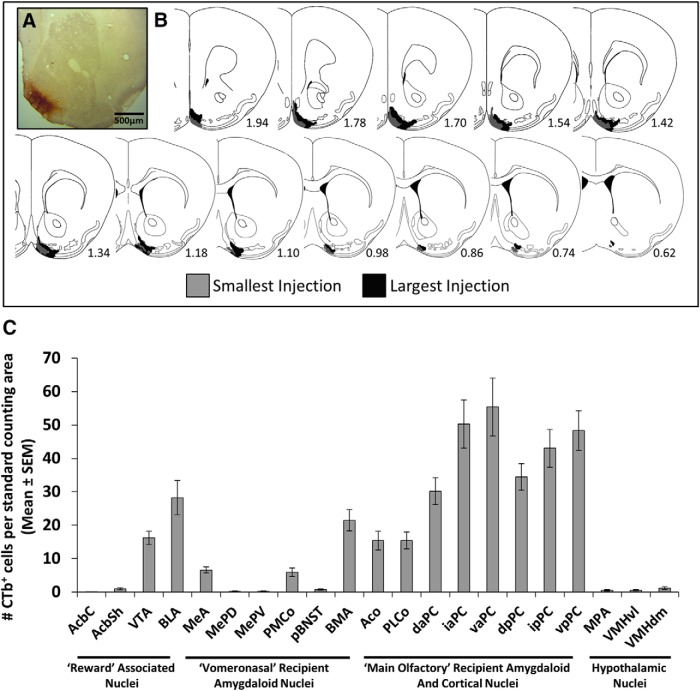
A, Representative photomicrograph showing a CTb injection site in the mOT. B, Schematic reconstruction of coronal sections of the largest (black) and smallest (gray) injection sites in female mice given CTb injections in the mOT. Sections are ordered sequentially from anterior (left) to posterior (right), with the numbers shown representing the distance (in millimeters) anterior to bregma for each section. Adapted from Franklin and Paxinos (2008). C, Mean (±SEM) number of back-labeled CTb+ cell bodies in various forebrain sites in female mice given CTb injections into the mOT 5 d previously (n = 30). AcbC, nucleus accumbens core; BMA, basomedial amygdala; Aco, anterolateral cortical amygdala; daPC, anterodosal PC; iaPC, intermediate PC; vaPC, ventral PC; dpPC, posterodorsal PC; ipPC, intermediate PC; MPA, medial preoptic area; VMHvl, ventrolateral portion of the ventromedial hypothalamus; VMHdm, dorsomedial portion of the ventromedial hypothalamus.